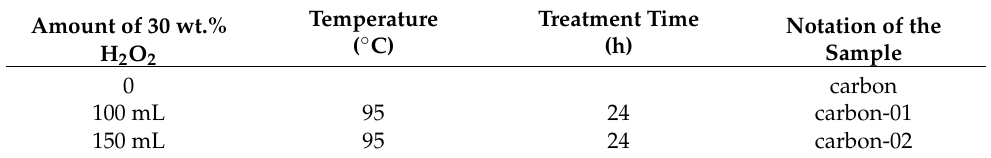
Table 1. Pretreatment condition of carbon black (10 g) treated with various amounts of H 2 O 2 . Amount of 30